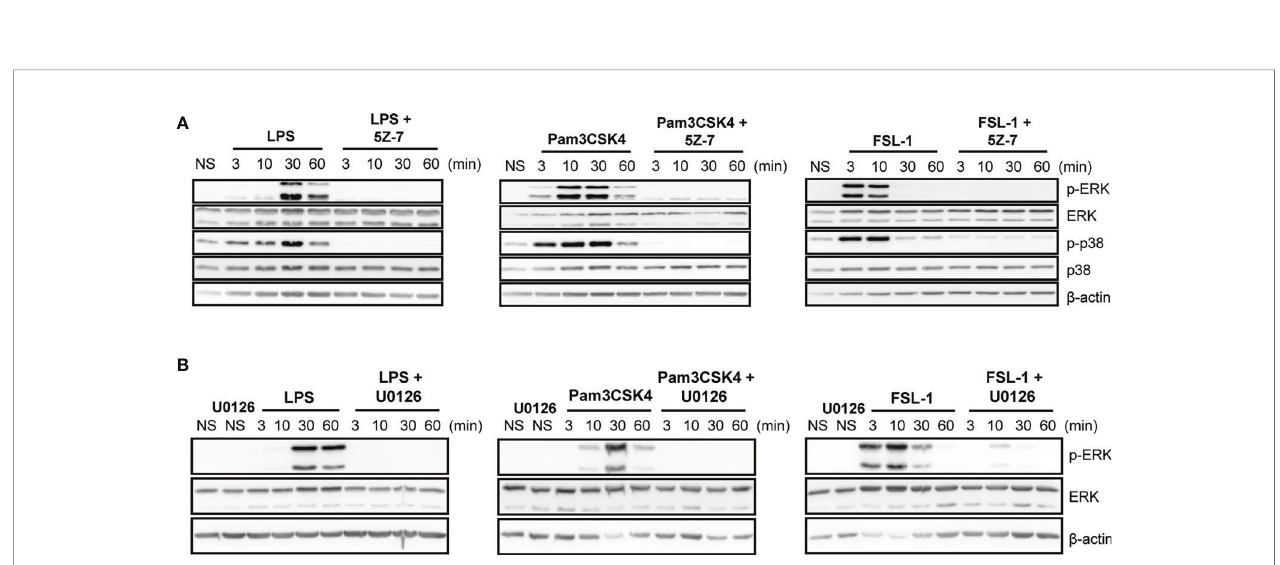
FIGURE 3 | TAK1 and MEK1/2 are upstream activators of ERK and p38 regardless of the TLR stimuli in peritoneal macrophages. Peritoneal macrophages were pretreated with 1 µM 5Z-7-oxzeaenol ( “ 5Z-7 ” ) (A) or with 1 µM U0126 (B) for 30 min. Cells were left unstimulated (NS) or stimulated with LPS (100 ng/mL), Pam3CSK4 (1 µg/mL) and FSL-1 (100 ng/mL) at 3, 10, 30 and 60 min. A representative western blot is shown of three independent experiments.